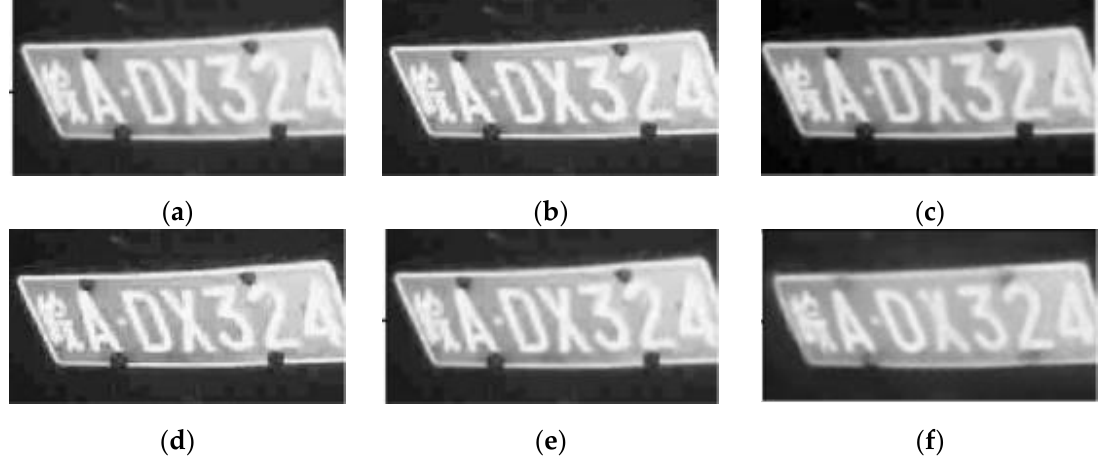
Figure 9. ( a ) Ground Truth ( b ) Bicubic; ( c ) SRCNN; ( d ) ESPCN; ( e ) SRGAN; ( f ) Our algorithm.